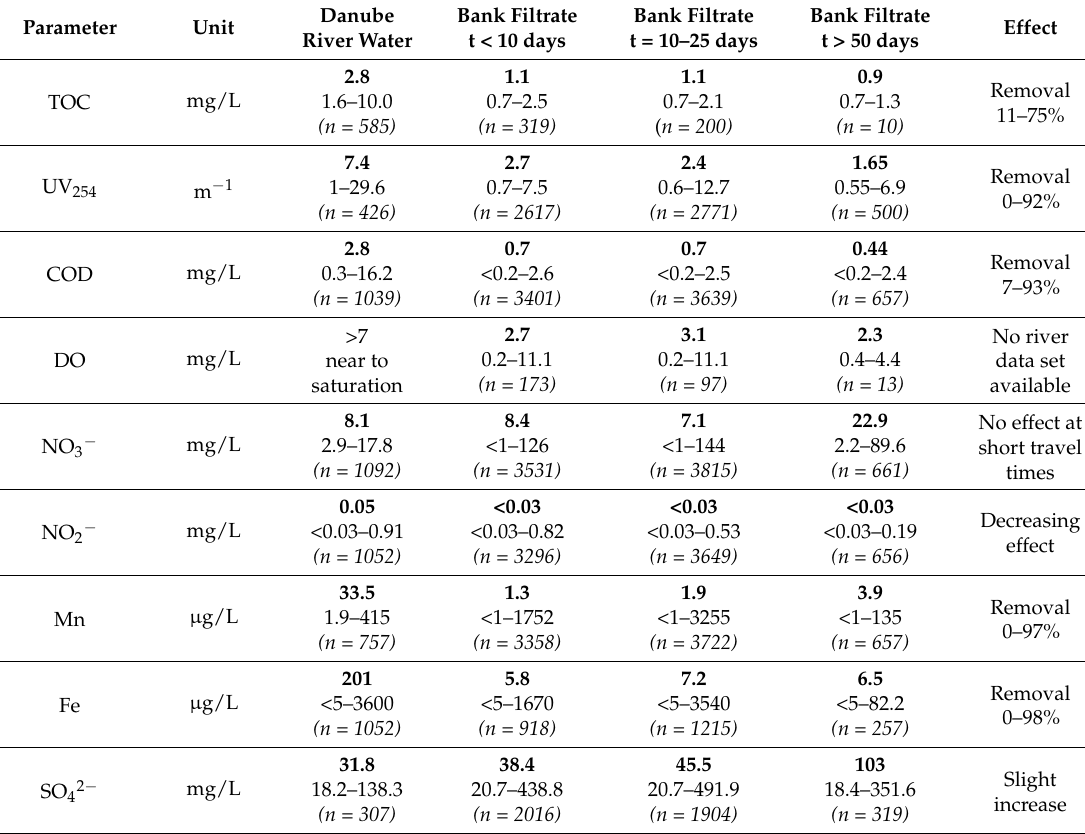
Table 3. Redox related parameters, median (min–max) values, Danube River water and bank filtrate with different travel time (t), Budapest,